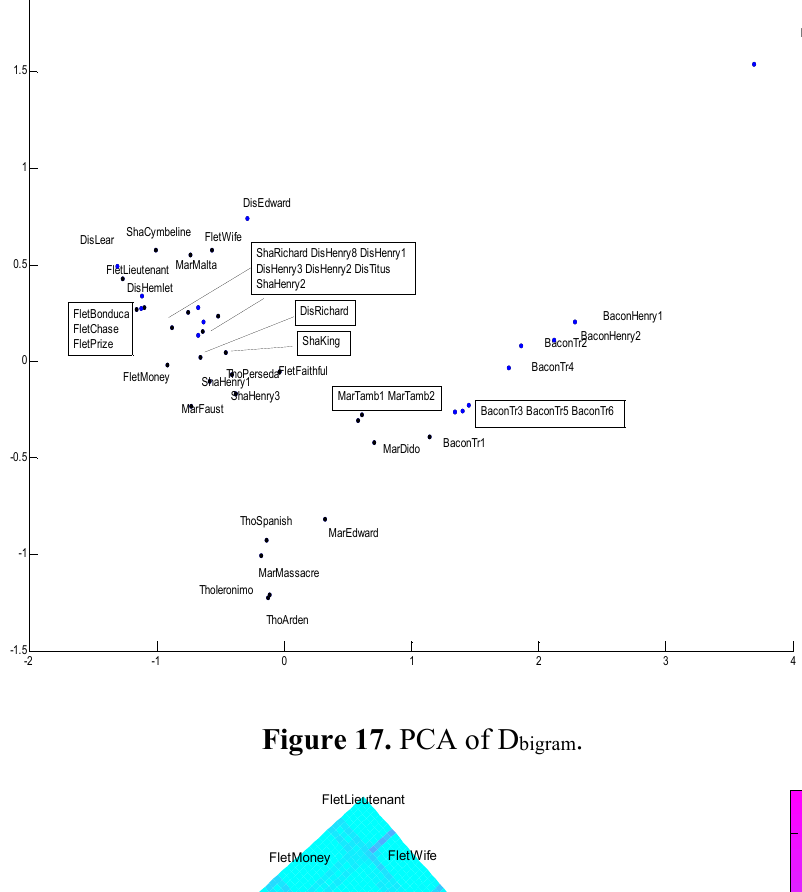
Figure 17. PCA of D bigram .